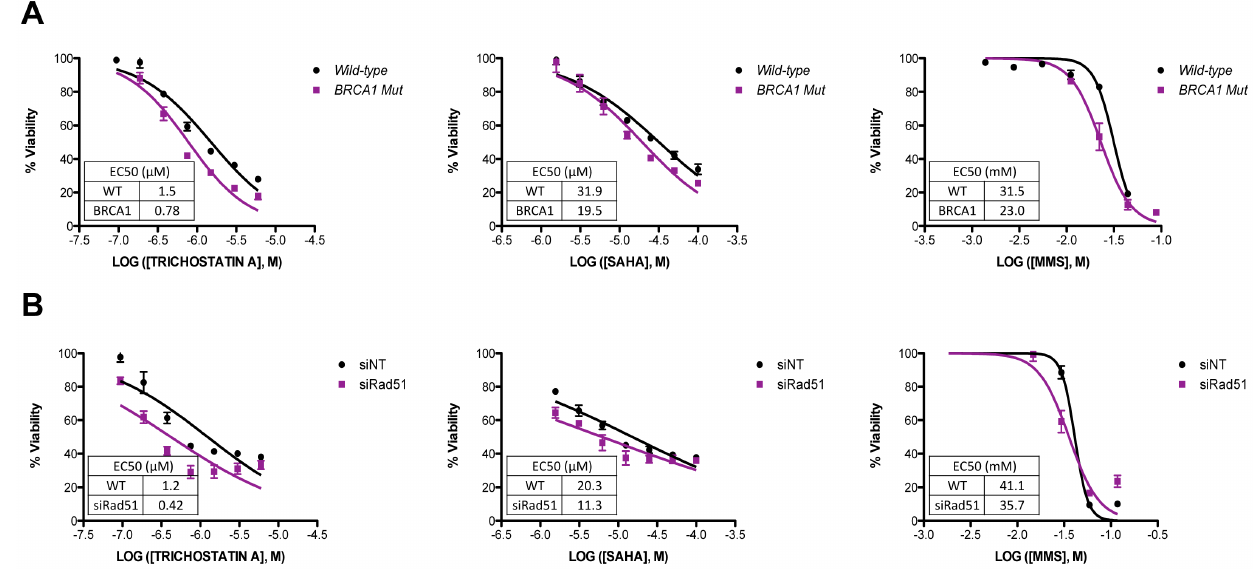
Figure 6. Viability of HDR deficient cells after treatment with HDACis. The indicated cells were treated for 48 hr with 0 to 1.5 m M TSA, 0 to 100 m M SAHA or 0 to 118 mM MMS. Viability was determined using CellTiter-Glo. The data represent the average of 3 independent experiments 6 SD. (A) HCC1937 cells, lacking a functional BRCA1 gene, or HC1937 cells complimented by BRCA1 cDNA expression (wild-type). EC50 differences between wild-type and BRCA1 after treatment with TSA and SAHA were significant at p=0.0009 and p=0.02 respectively. EC50 differences between wild-type and BRCA1 after MMS treatment were not significant p=0.07. (B) Hela cells after 2 6 24 hr transfection with either non-targeting siRNA or siRNA against RAD51 . EC50 differences between siNT and siRAD51 after treatment with TSA and SAHA were significant at p , 0.0001 and p=0.03 respectively. EC50 differences between siNT and siRAD51 after MMS treatment were not significant p=0.07.